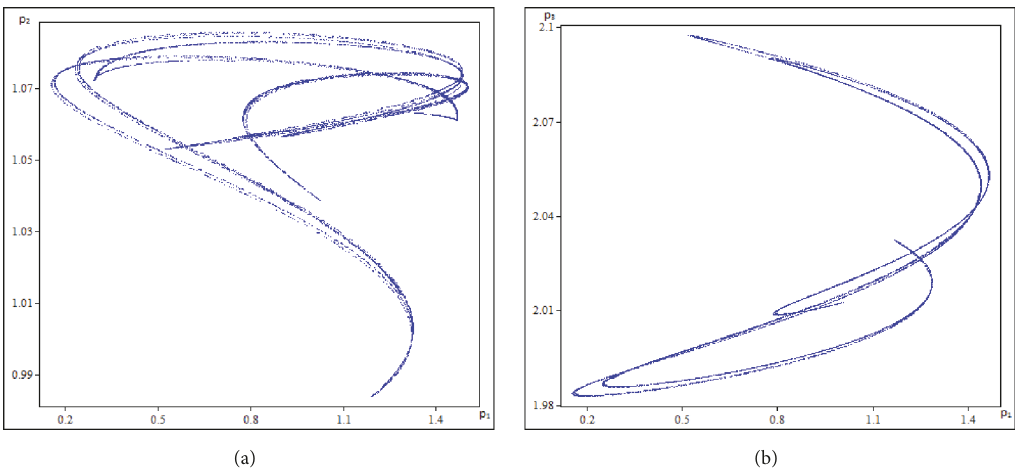
Figure 8: (a) The chaos attractor when 𝛼 is 0.93, 𝛽 = 0.25 , and 𝛾 is 0.15. (b) The chaos attractor when 𝛼 is 0.95, 𝛽 = 0.25 , and 𝛾 is 0.15.